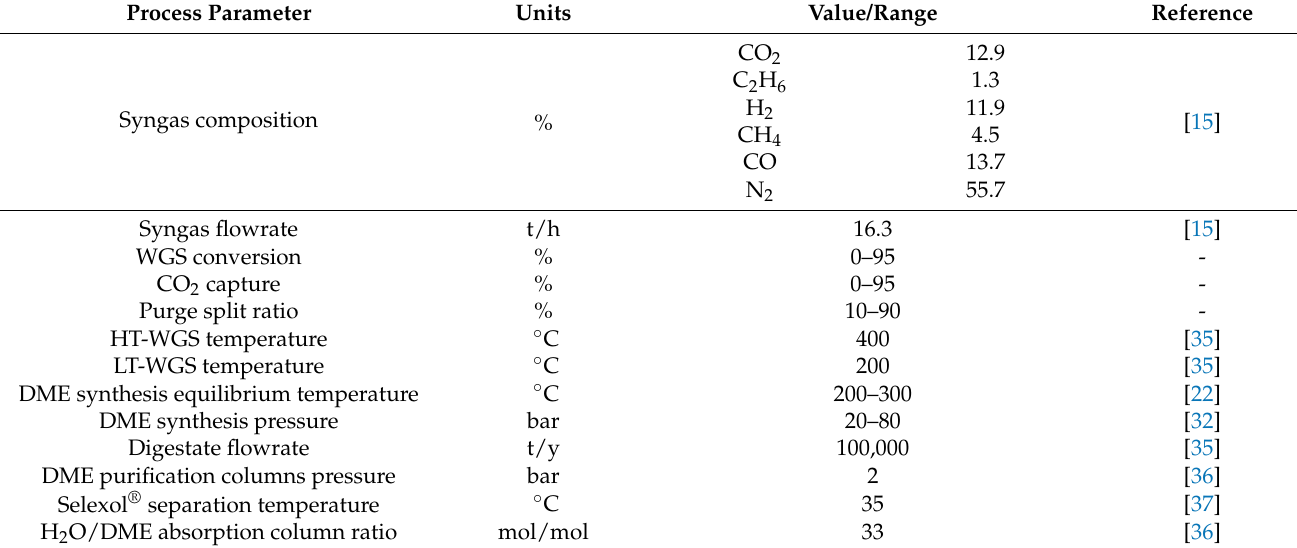
Table 1. Process parameter